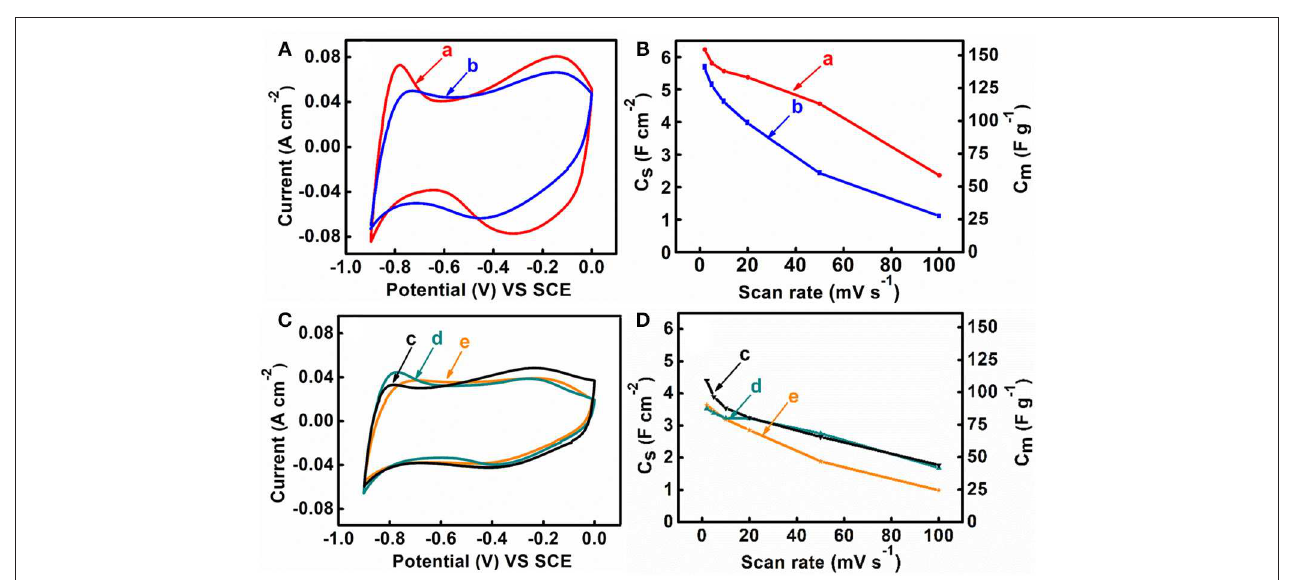
FIGURE 5 | (A,C) CVs and (B,D) capacitance vs. scan rate for (a) M-CB-MWCNT, (b) M-FH-CB-MWCNT, (c) M-PV-MWCNT, (d) M-AA-MWCNT and (e) M-CP-MWCNT electrodes.